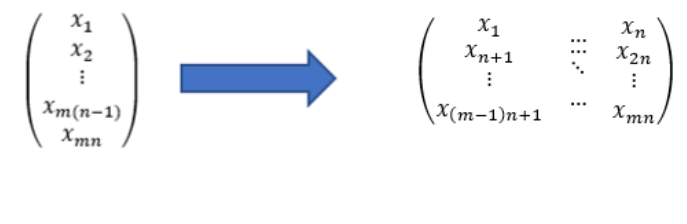
Figure 4. Illustration of reshaping of a vector into a two-dimensional matrix.